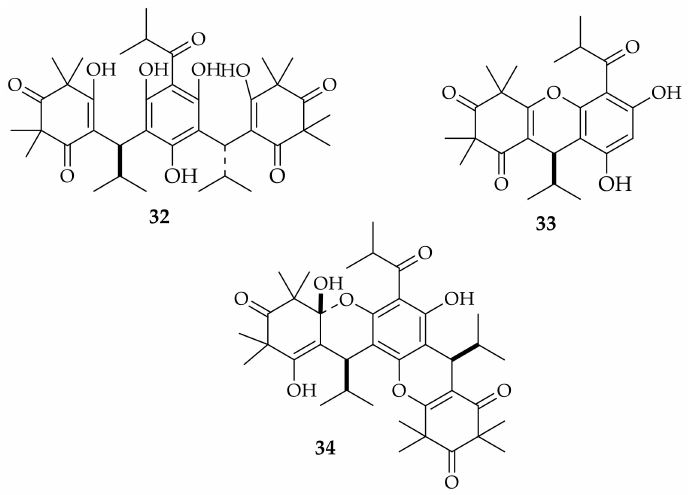
Figure 5. Structures of myrtocommulones: myrtucommulone A, B and D ( 32 – 34